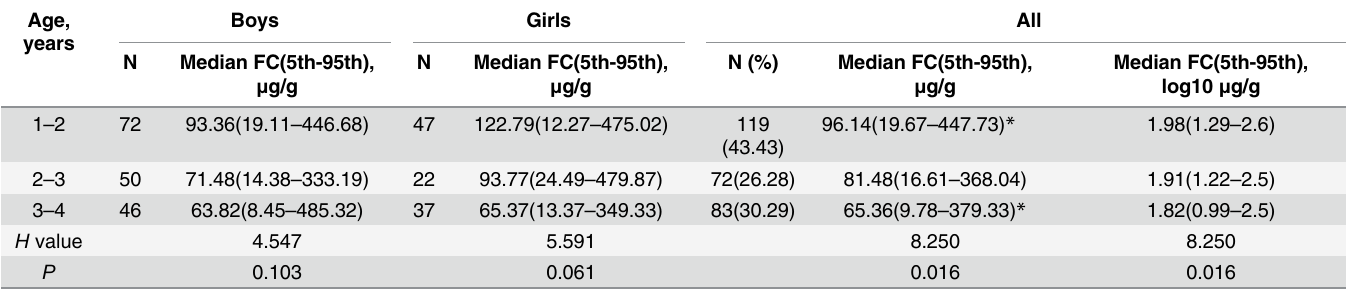
Table 2. Fecal calprotectin concentrations in apparently healthy